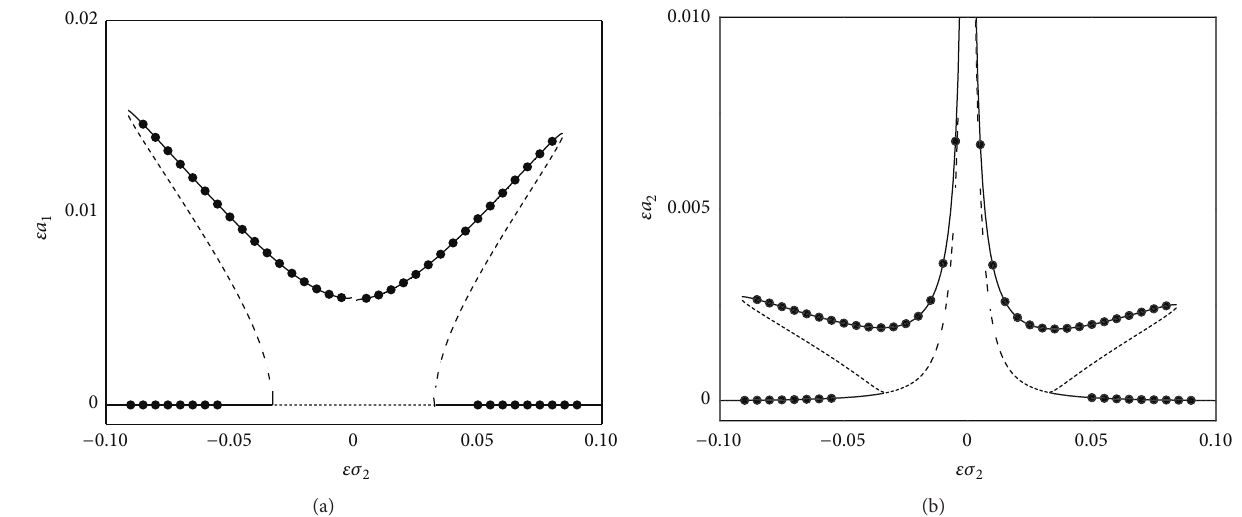
Figure 18: Comparisons in the first subharmonic resonance: (a) the first mode and (b) the second mode.